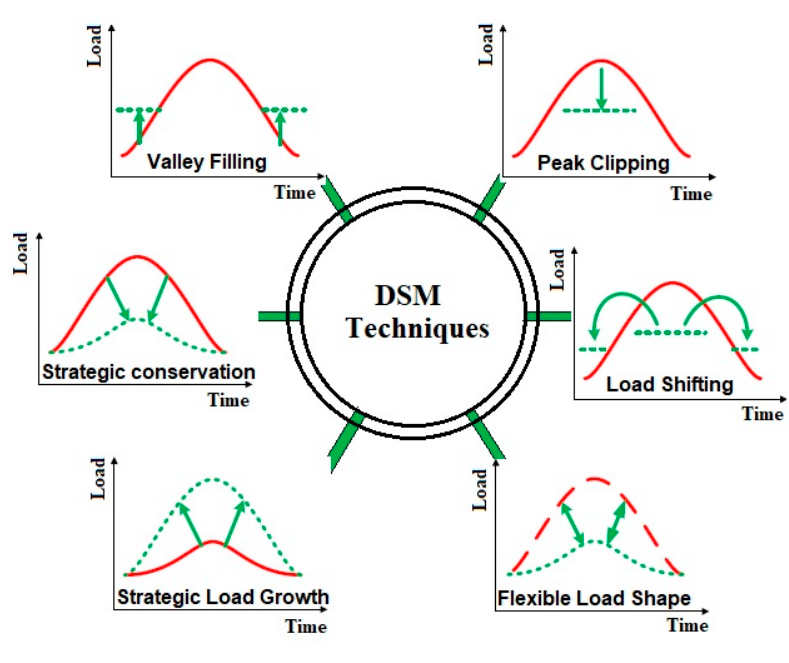
Figure 1. DSM techniques.